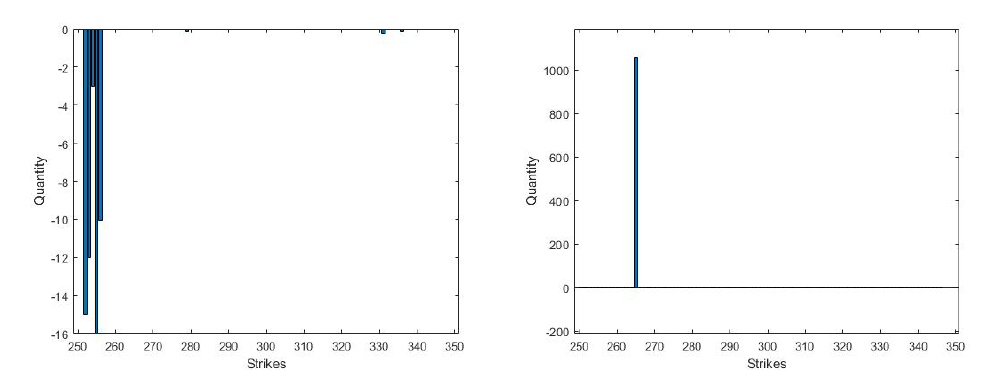
Figure 1. Optimized portfolio in the put options ( left ) and the call options ( right ).